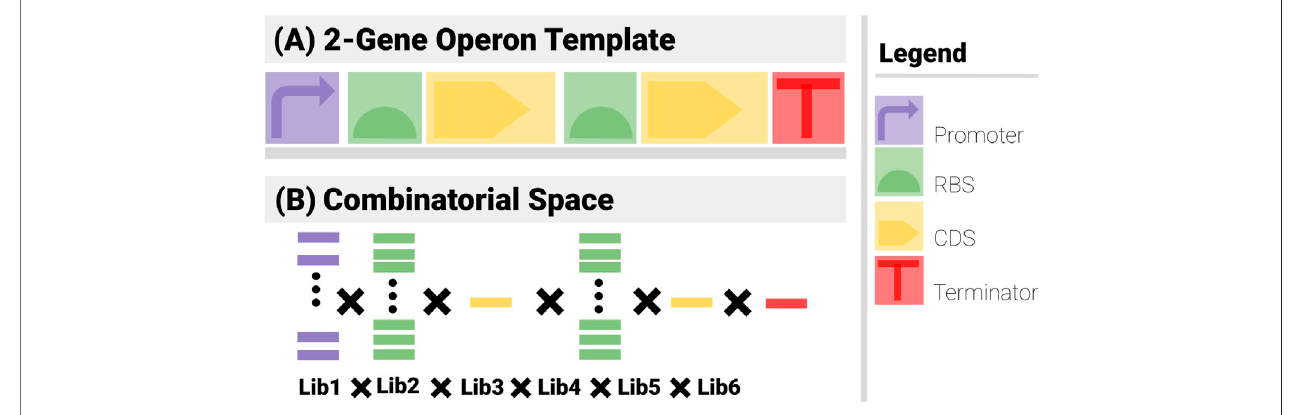
FIGURE3| Thetwosets ofsearchconstraints fora2-geneoperon. (A) Thetemplatespeci fi esthetypes ofthe components and theirpositionalarrangements. (B) The list of possible elements for each component yields the combinatorial element of the